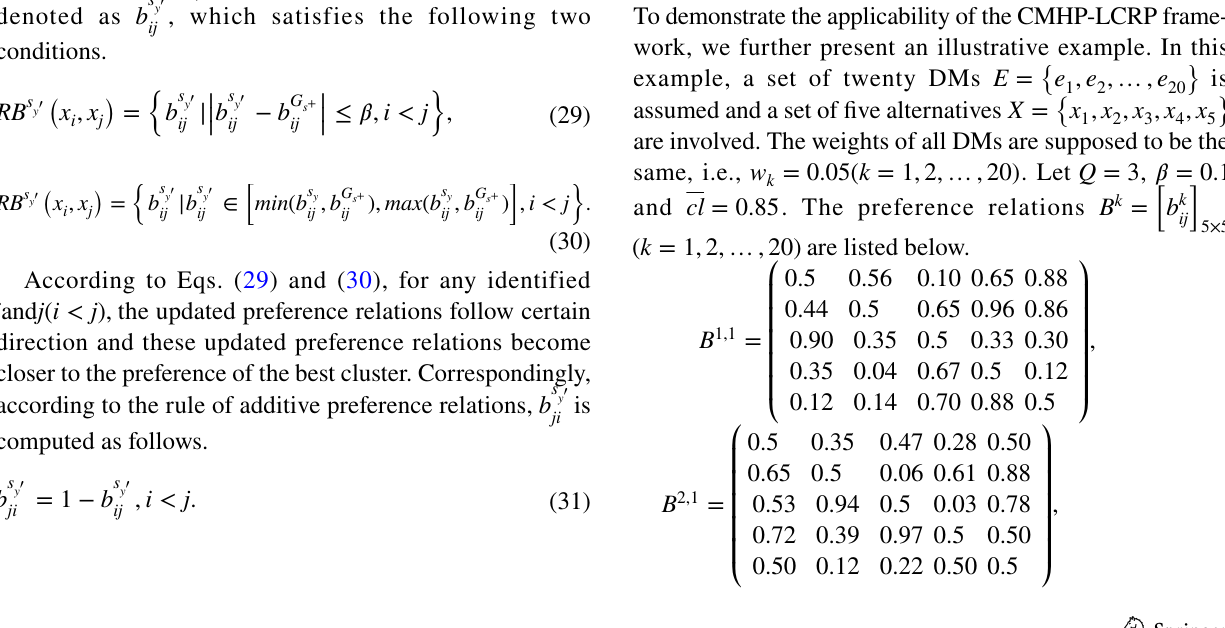
Algorithm 2 . CMHP-LCRP